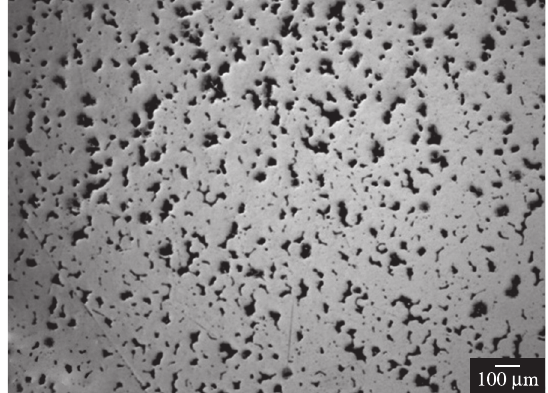
Figure 11. Microstructure of a sample pressed at 600 MPa and sintered on the cathode at 1473 K for 3600 seconds.